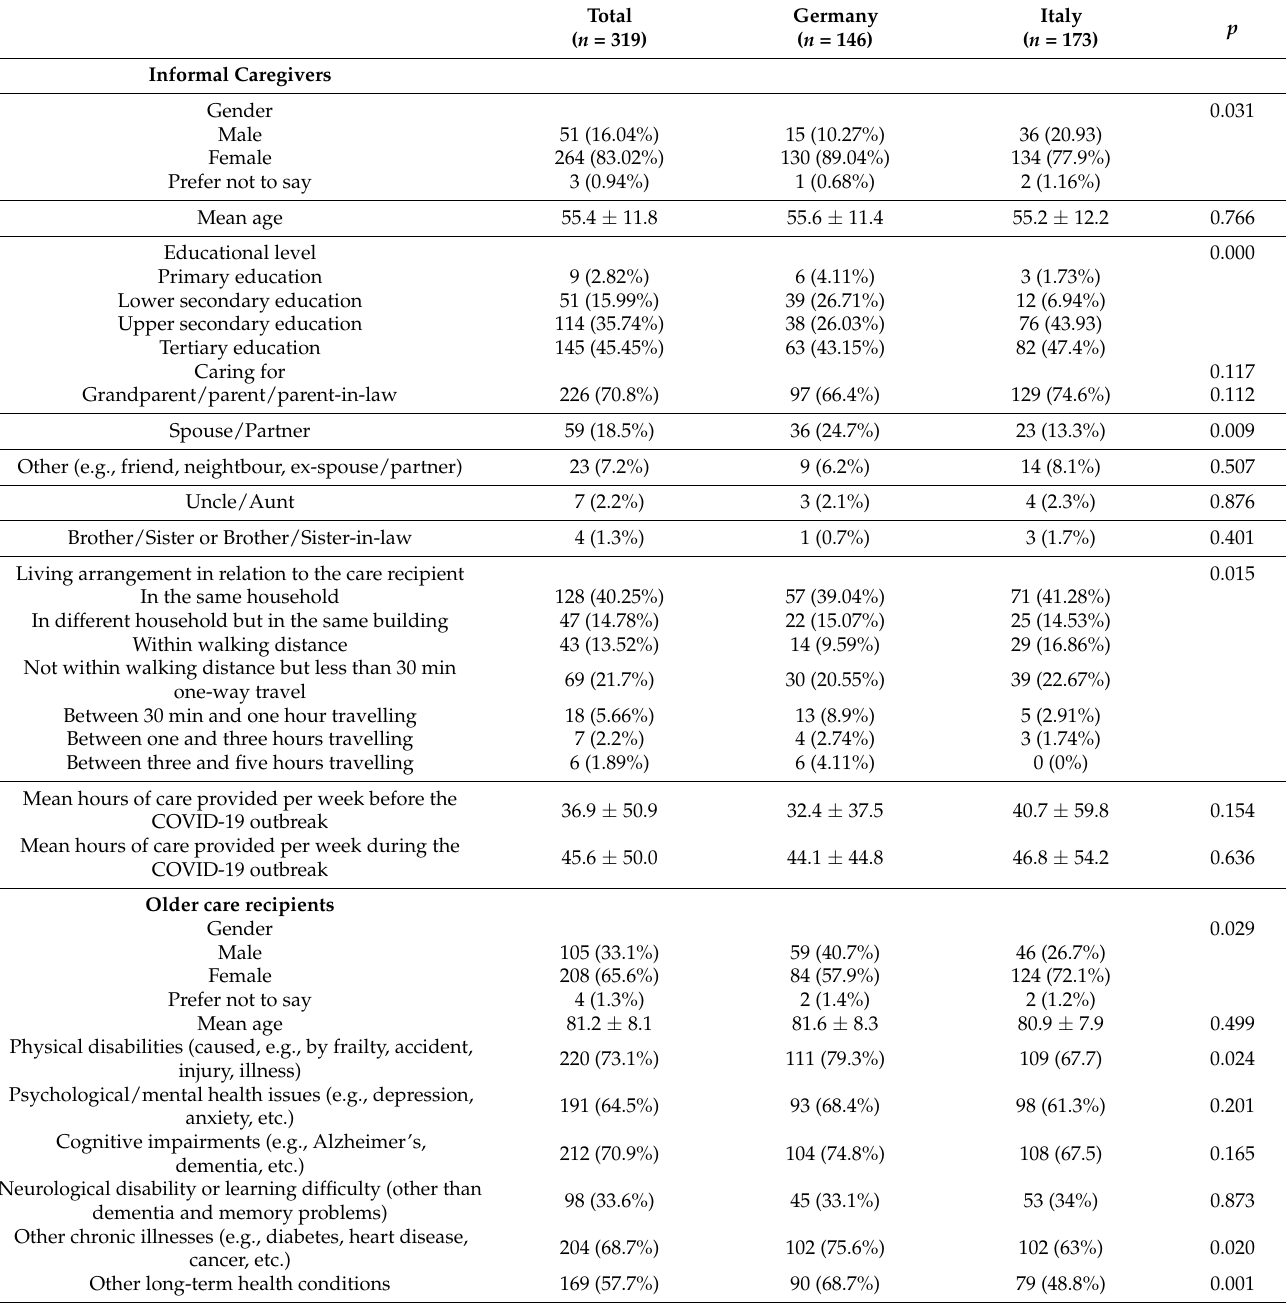
Table 1. Informal caregivers’ description and living